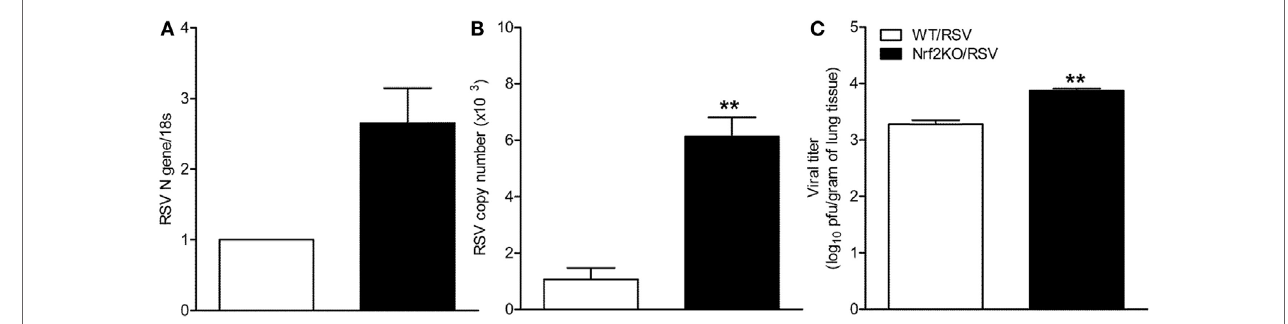
FigUre 2 | NF-E2-related factor 2 (Nrf2) KO mice have increased viral replication in the lung. Nrf2 KO and wild type (WT) mice were infected intranasally with 10 7 plaque-forming units of respiratory syncytial virus (RSV) or PBS. Lungs were excised and viral replication was determined by quantitative real-time PCR (RT-PCR) and by plaque assay. At day 1 post-infection RSV N gene (a) and RSV genome copy number (B) in the lung were determined by RT-PCR. (c) Viral titration was performed at day 5 post-infection by a methylcellulose plaque assay. Data are expressed as mean ± SEM ( n = 3–4 mice/group). ** p < 0.01 when compared with WT/RSV at days 1 and 5